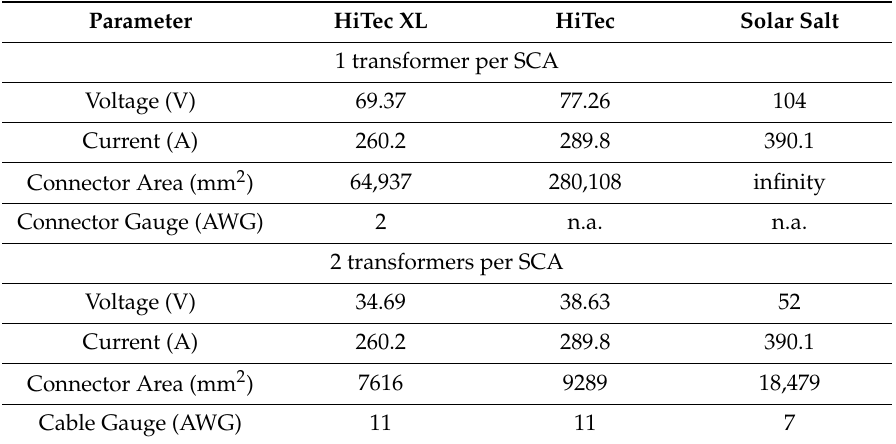
Table 7. Necessary electrical system characteristics to meet the target condition of a one-day melting time for a tube with a compromised vacuum. NA represents that no American wire gauge (AWG) rating is su ffi